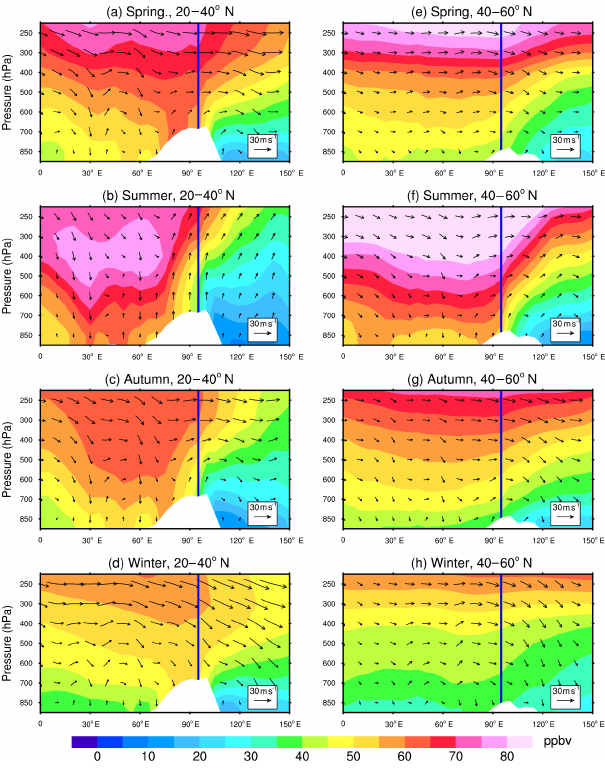
Figure 7. Longitude–pressure cross sections of foreign ozone (in colour) and wind field (arrows) averaged between 20–40 ◦ N ( a – d ) and 40–60 ◦ N ( e – h ) in 2005. The white areas indicate topog- raphy. The blue lines indicate the western border of East Asia. The vertical velocities in the p coordinates are enlarged 1000 times for illustration purposes.